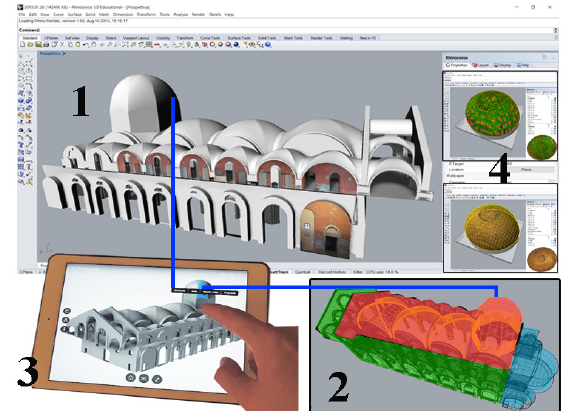
Fig. 8 Masegra Castle Revit model (1), BIM for structural analysis (2), BIM for VR/AR (4). HBIM: in red the elements where GoG 10 has been used, in green GoG09 and in blue the other types of GoGs (3).